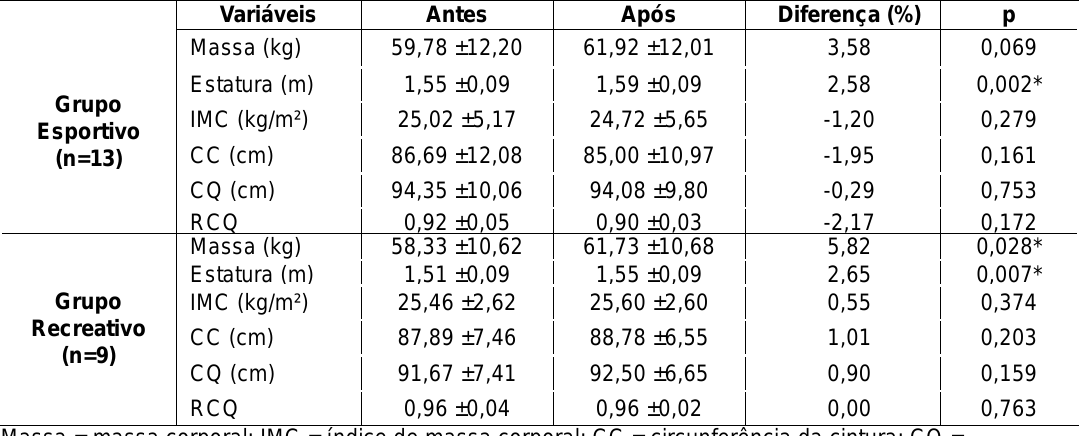
Tabela 2. Perfil antropométrico dos adolescentes no Grupo Esportivo e no Grupo Recreativo, antes e após os programas de exercício